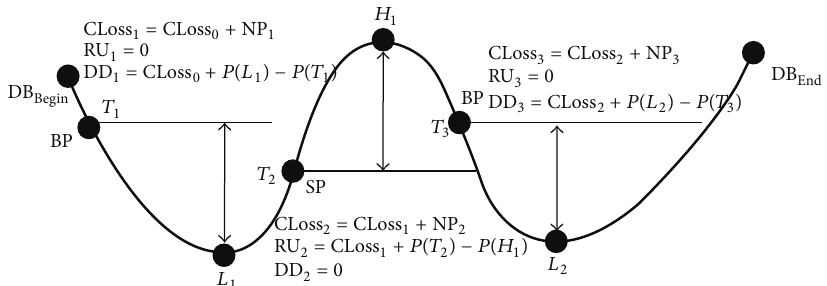
Figure 3: A stock price versus trading time curve for computing the risk of a trading